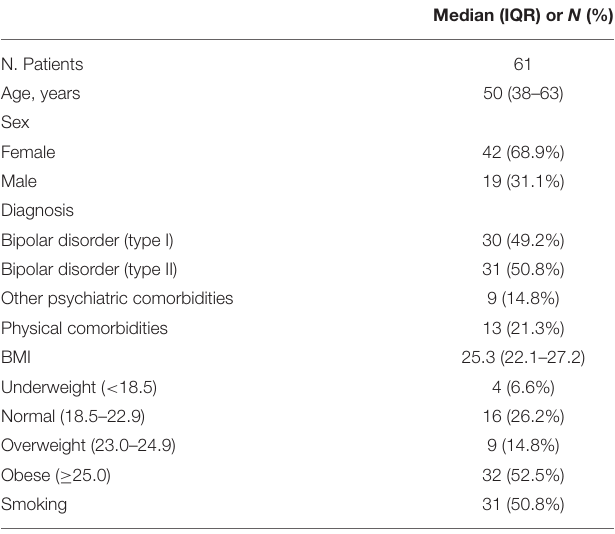
TABLE 1 | Patients